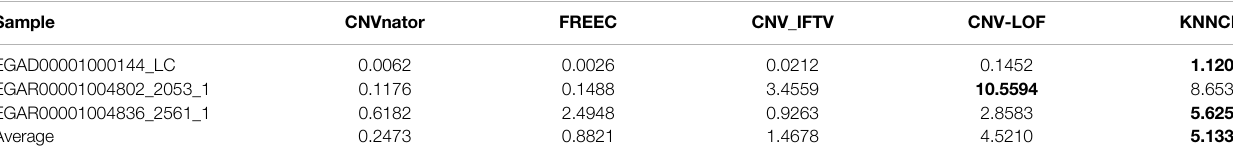
TABLE 2 | ODS on three genome-wide samples (22 autosome chromosomes).